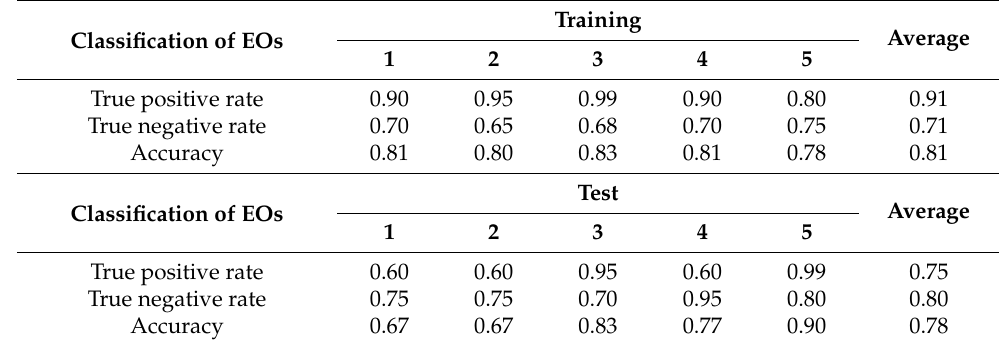
Table 1. Accuracy statistics of the training and tests groups of the 5-fold external cross-validation of the Self-Organizing map (SOM).